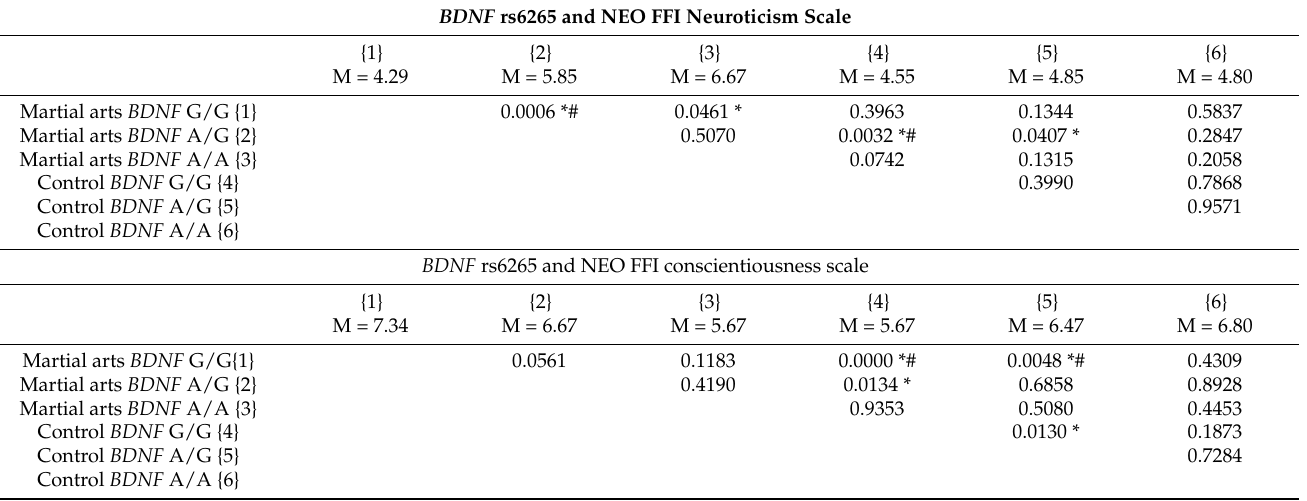
Table 4. Post-hoc LSD (least significant difference) analysis of interactions between martial arts/- Control and BDNF rs6265 and neuroticism scale and conscientiousness